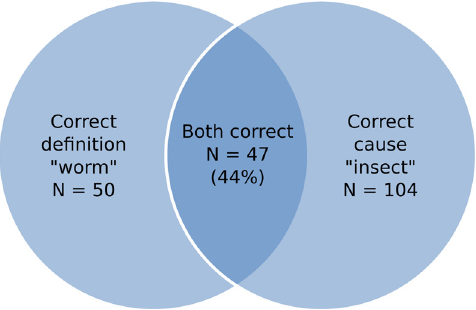
Fig 2. Venn diagram showing the survey participants ’ knowledge of the correct definition and cause of onchocerciasis.